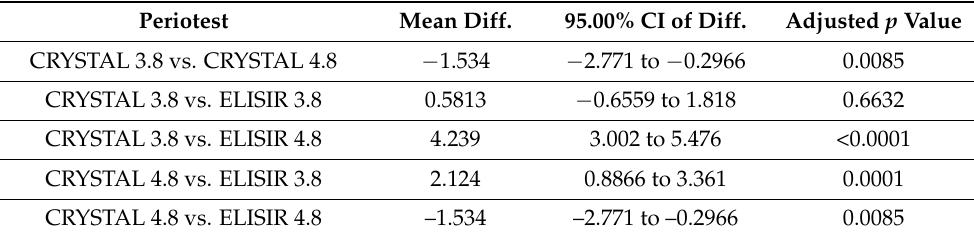
Table 6. ANOVA post-hoc of Periotest comparisons for the study